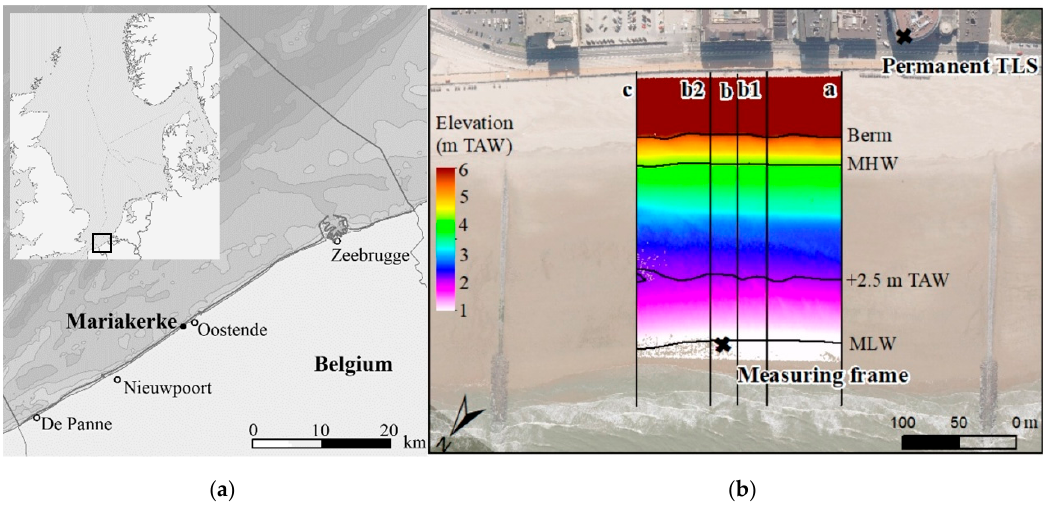
Figure 1. ( a ) Overview maps of the North Sea and the Belgian coast; ( b ) Digital Elevation Model (DEM) of the study site with the position of the intertidal measuring frame, cross-shore topographic profiles, the permanent Terrestrial Laser Scanner (TLS), and the berm, Mean High Water (MHW), 2.5 m TAW (relative to the lowest astronomical tide), and Mean Low Water (MLW)